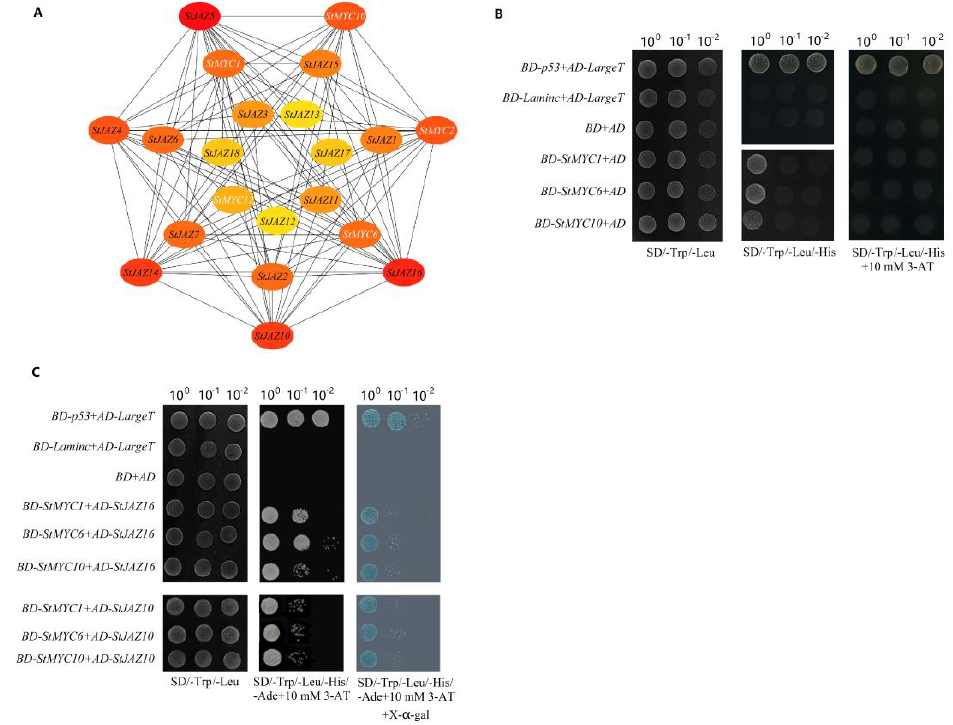
Figure 5. PPI network analysis of StJAZ and StMYC genes. ( A ) The PPI network of StJAZs and StMYCs; ( B ) The result of self-activation detection; ( C ) Yeast two−hybrid interactions between StJAZ proteins and StMYCs.